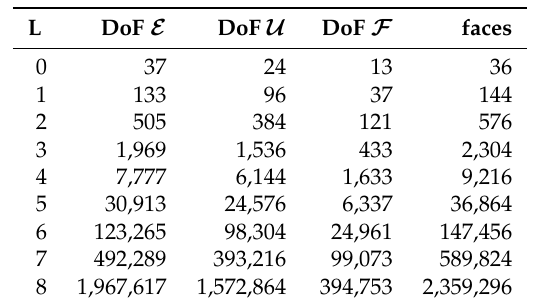
Table A2. DoF number and total face number of the simple planar 2D geometry at level L, extracted from our former paper